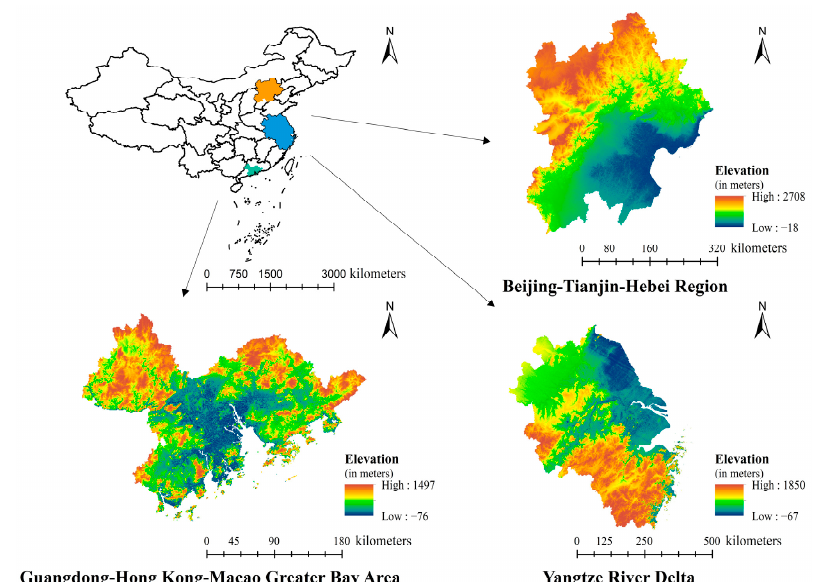
Figure 1. The study area locations.